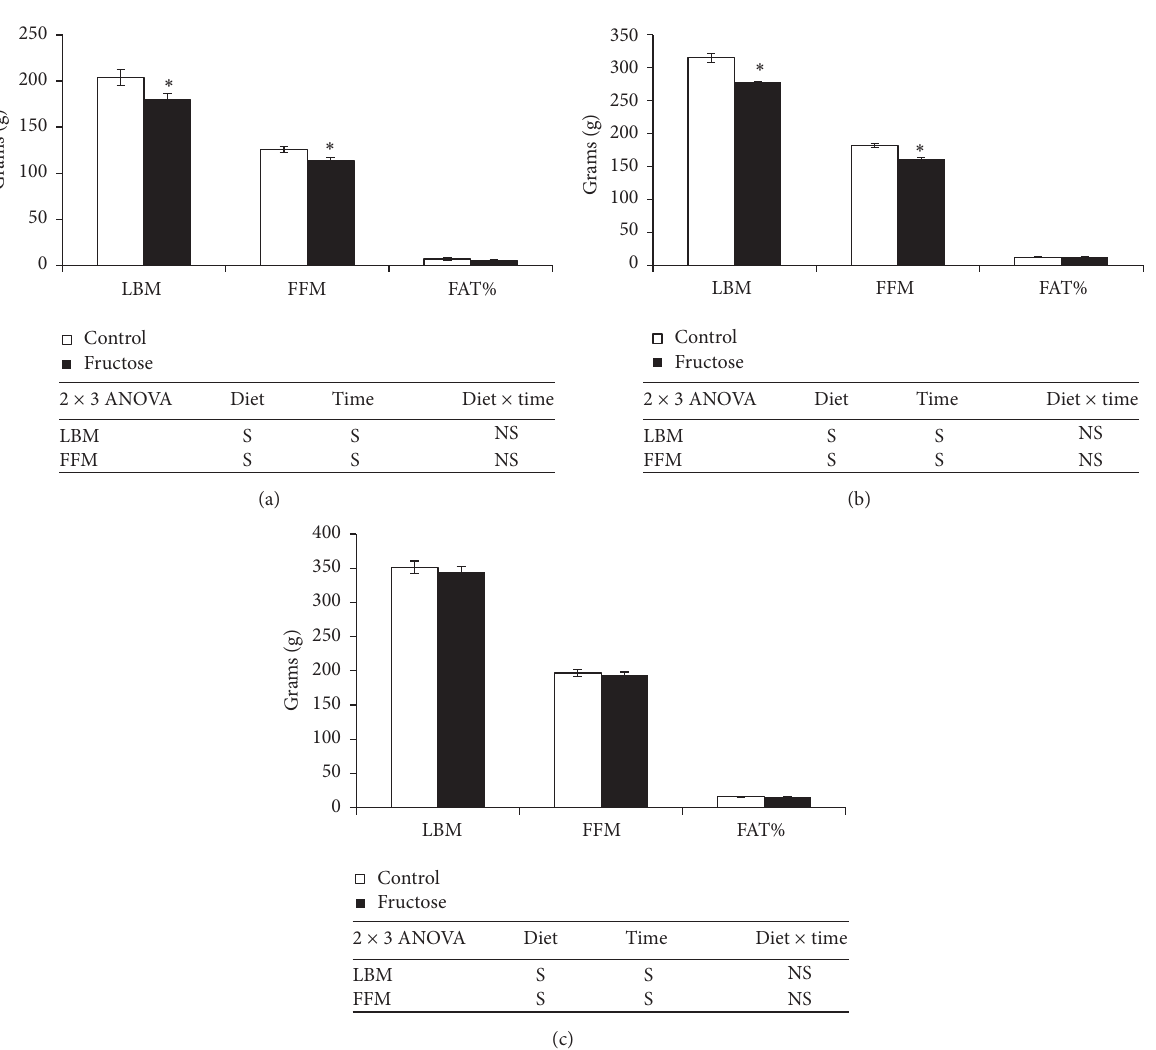
Figure 3: Body composition of control and fructose diet-fed rats. (a) 4 weeks. (b) 12 weeks. (c) 24 weeks. Values are in mean ± SE of 8 animals from each group at three time points. ∗ Significance at 𝑝 ≤ 0.05 by Student’s 𝑡 -test. Statistical significance of diet, time, and diet ∗ time on individual parameters is also analyzed by two-way ANOVA. “S” indicates “significant” ( 𝑝 ≤ 0.05 ); “NS” indicates “not